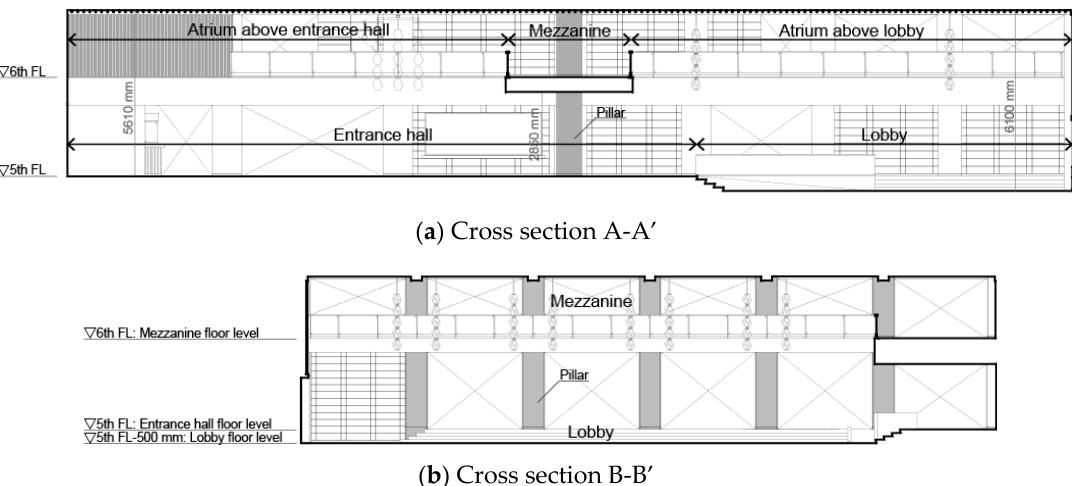
Figure 3. Sound sources and measurement points on the ( a ) fifth floor and ( b ) sixth floor of the measurement items of No.2 to No. 5 in Table 1.